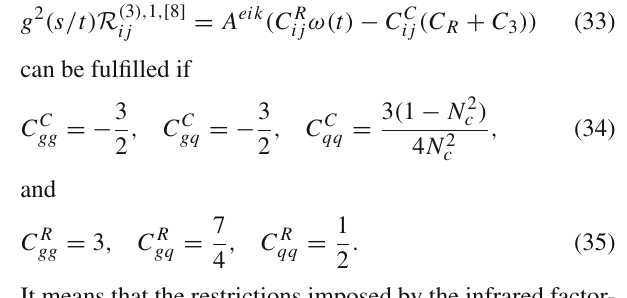
Fig. 4 Diagrammatic representation of A